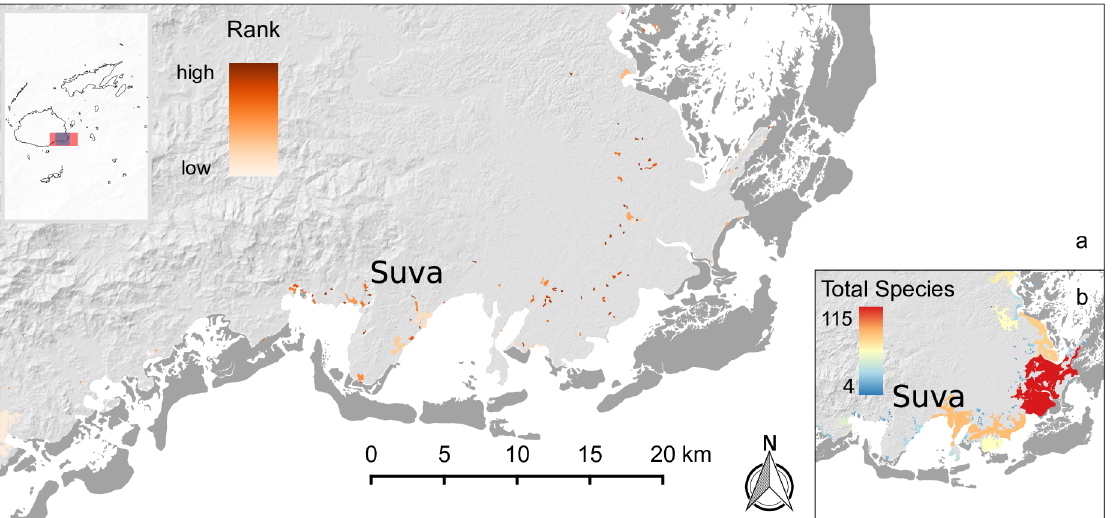
Fig 6. Priority sites for biodiversity services. The highest ranked priority mangrove for biodiversity was actually within the town limits of Suva and was the second smallest mangrove stand mapped (530 m 2 ; panel a, red inset polygon). Priority mangroves contrast greatly with mangroves having the highest overall biodiversity benefit ( S ), for example, around the Rewa Delta area (panel b, blue inset polygon). Dark grey areas are coral reefs.